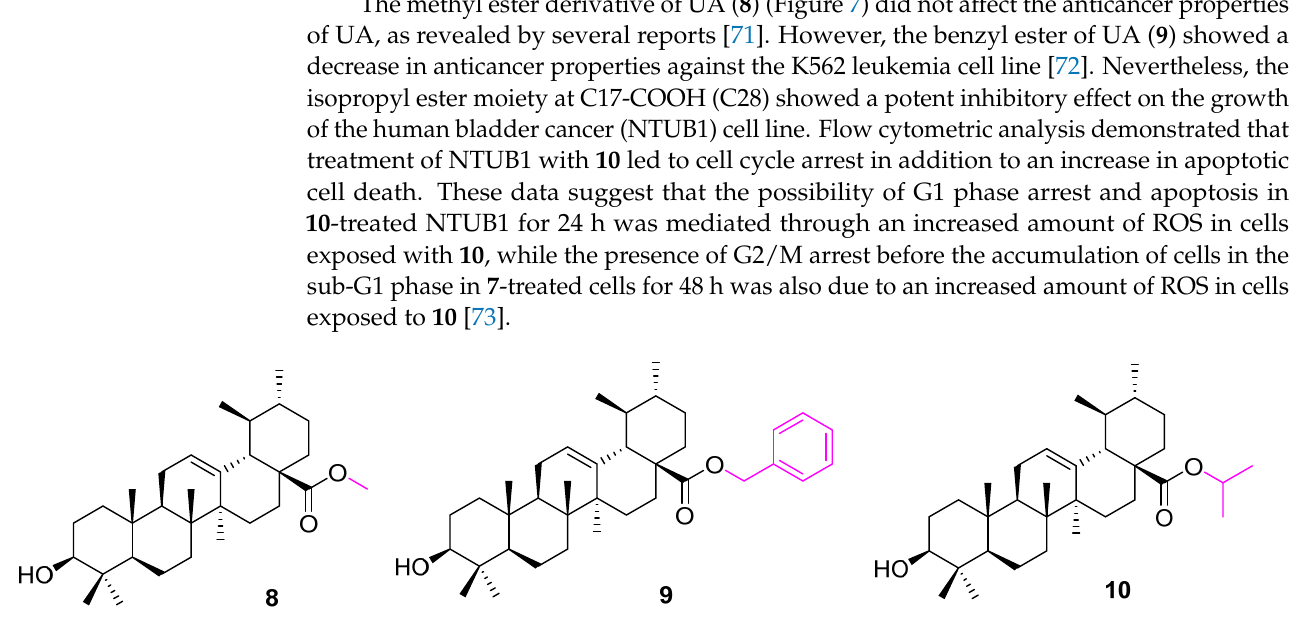
Figure 7. Structure of 8 , 9 , 10 .